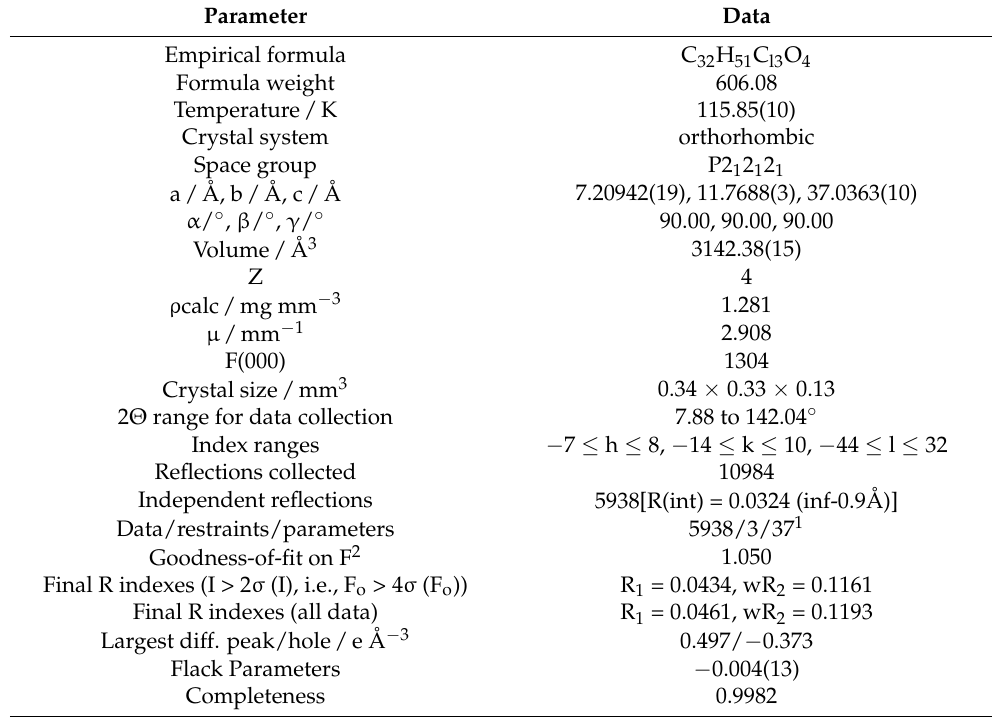
Table 2. Crystal data and structure refinement of compound 1 .